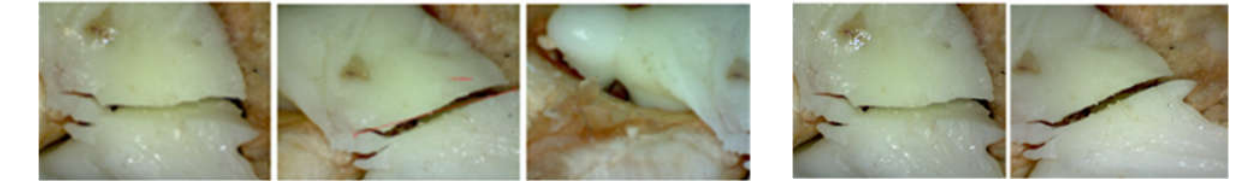
Figure 20. Micro fissures in the orthopaedic prosthesis analysed under the microscope.